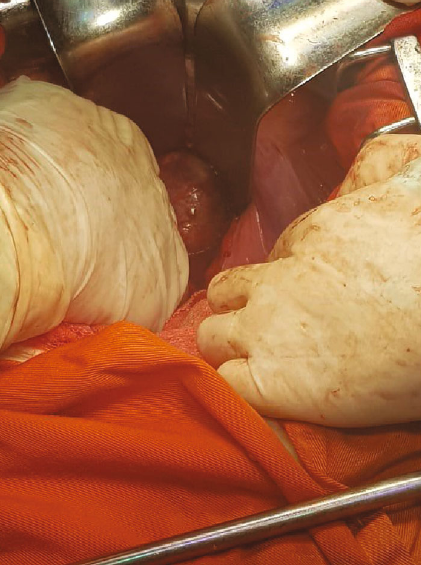
Figure 3: Preoperative aspect of the